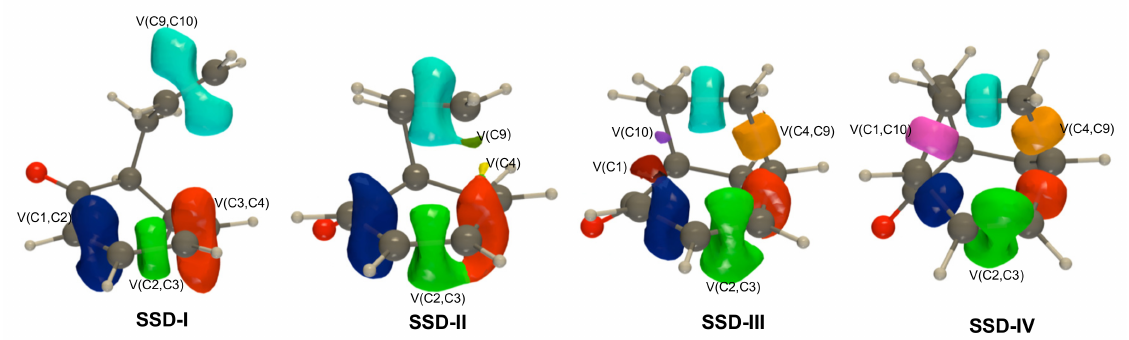
Scheme 4. Curly arrow representations of the main electron density flows of the reaction from 2 to 4 .